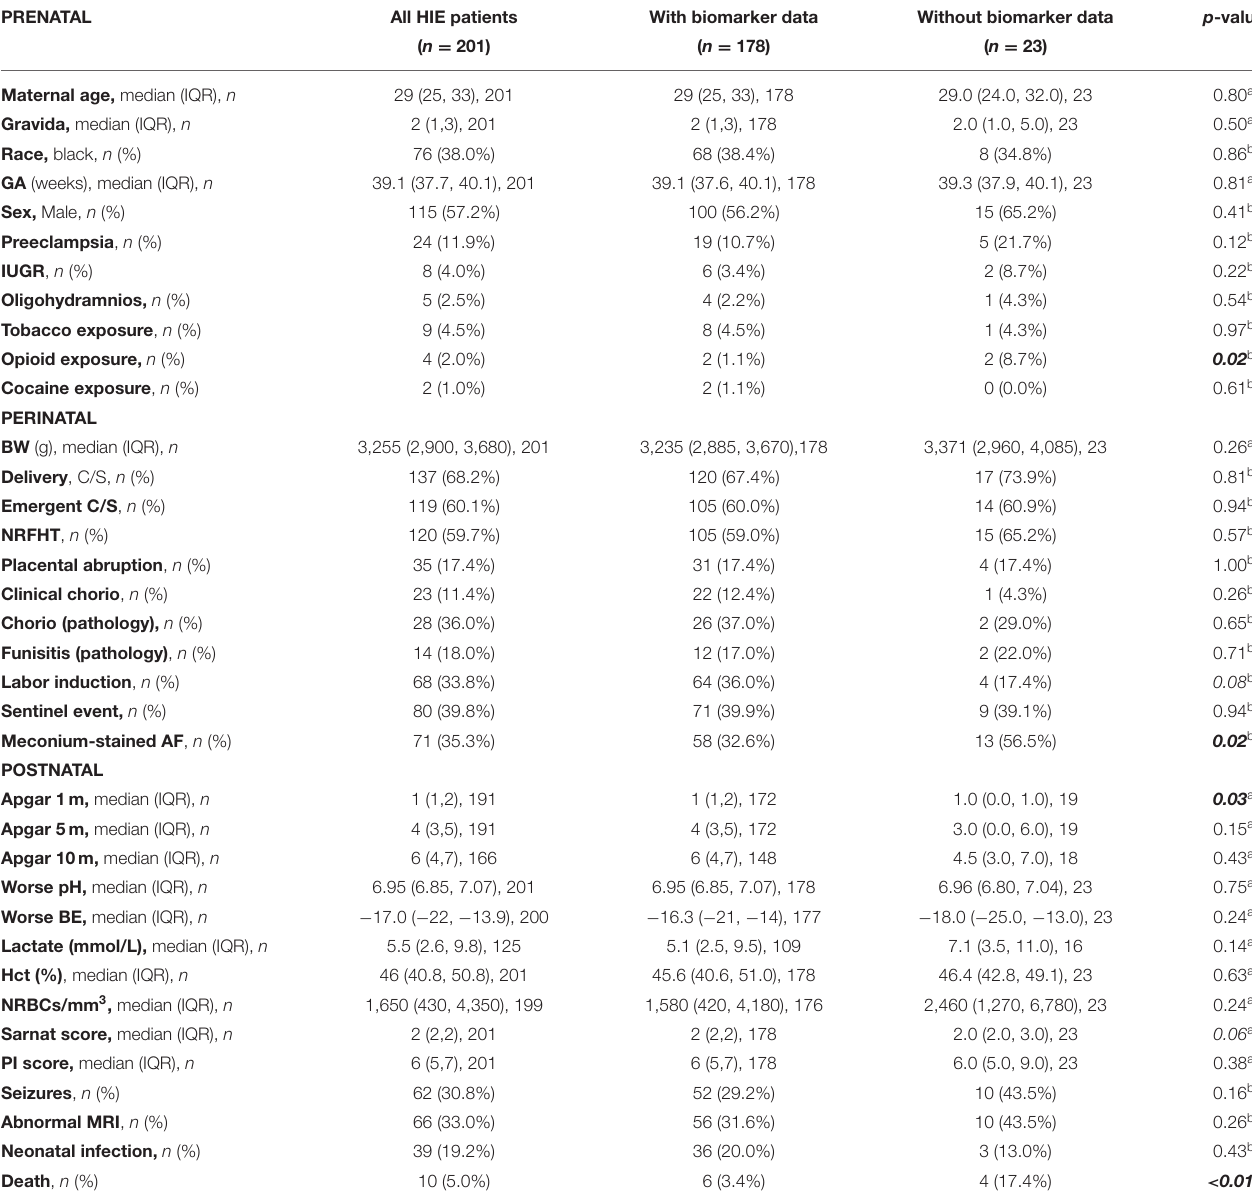
TABLE 1 | Summary of prenatal, perinatal, and postnatal patient variables. PRENATAL All HIE patients With biomarker data Without biomarker